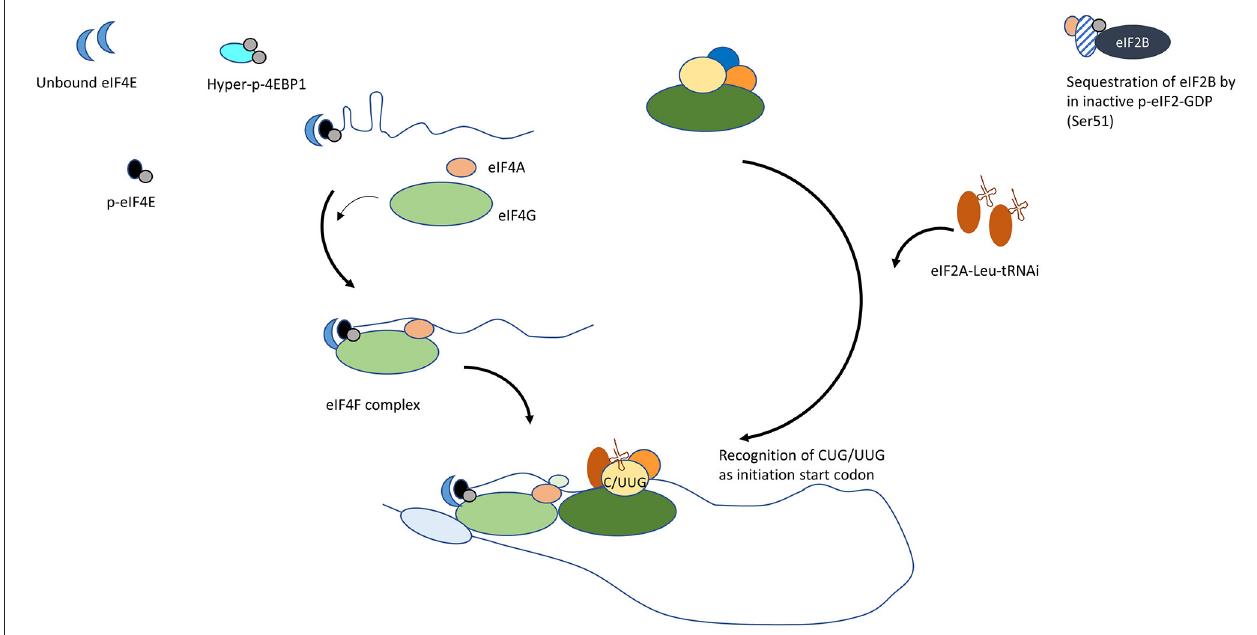
FIGURE 2 | Mechanisms by which conventional translation initiation is disrupted in cancer cells. (1) Increase in unbound eIF4E. Upregulation in eIF4E transcription, reduced 4EBP or hyperphosphorylated 4EBP supports the formation of the eIF4F complex at 5 ′ mRNA. (2) MNK- dependent phosphorylation of eIF4E. Phospho-eIF4E promotes eIF4G interaction. (3) Increase in alternate Leu-tRNAi carrier, eIF2A. Refractory to kinases that inactivate eIF2, eIF2A engages to form PIC and initiates translation at alternative ORFs.